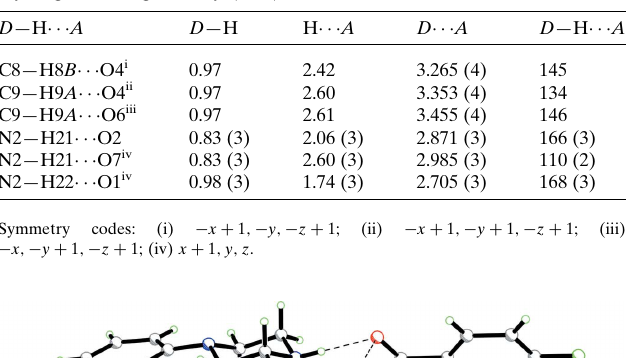
Symmetry codes: (i) (cid:3) x þ 1 ; (cid:3) y ; (cid:3) z þ 1; (ii) (cid:3) x ; (cid:3) y þ 1 ; (cid:3) z þ 1; (iii) x þ 1 ; y ; z . Table 7 Hydrogen-bond geometry (A˚ , (cid:5) ) for 8 .